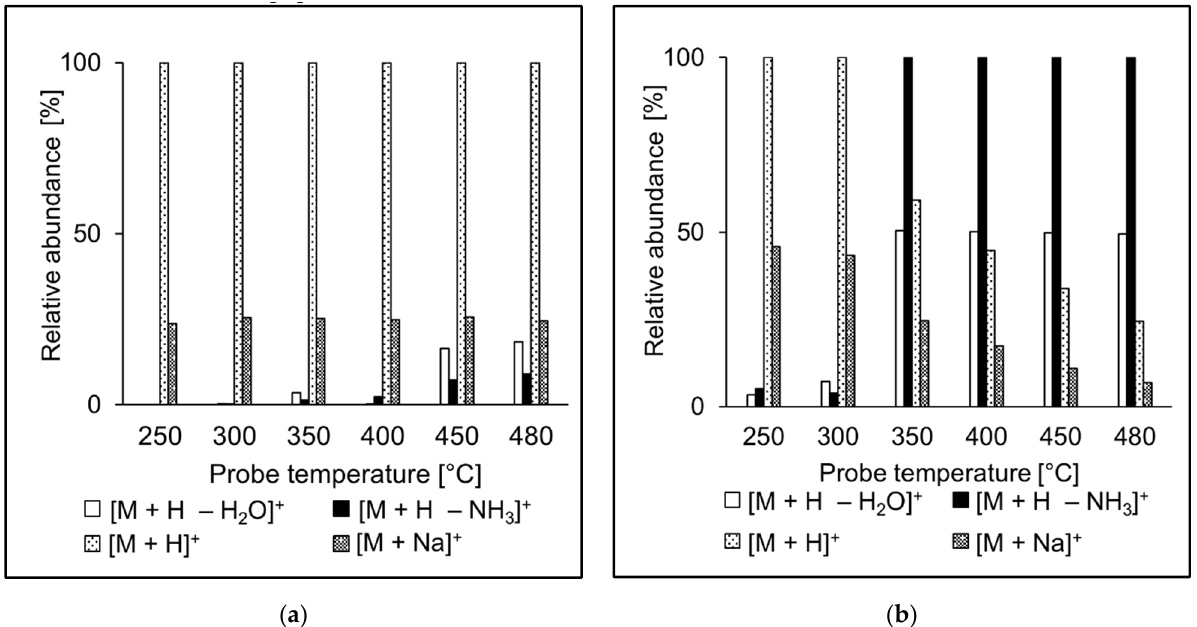
Figure 5. Effect of the probe temperature on the relative abundances of major ions in ( a ) APCI and ( b ) APPI full scan mass spectra of QTALVELLK. Data obtained by FIA using methanol/water (80:20 v/v) mobile phase.